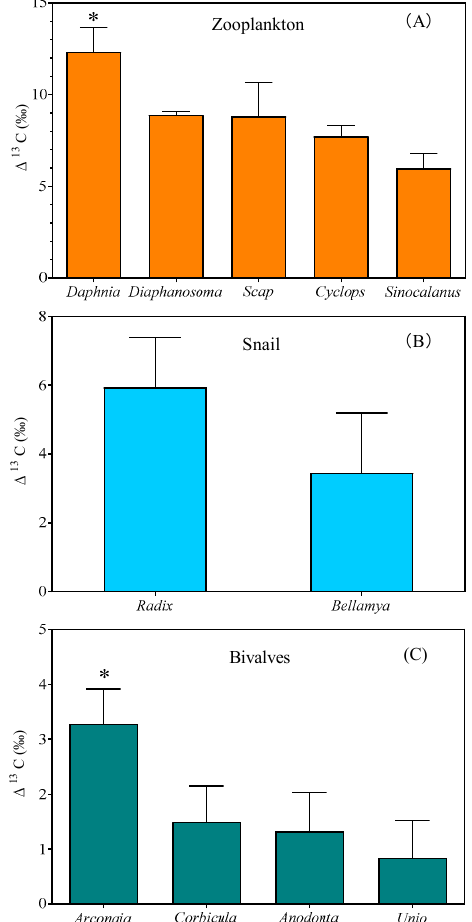
Figure 2. Comparison of 13 C enrichment ( ∆ δ 13 C) of the di ff erent species of cladocerans, copepods, snails and bivalves on δ 13 C peak days during the experiment. Data are presented as averages with SD error bars ( n = 3). Note: * indicate significant di ff erences than other species in each group. ( A ) cladocerans ( Daphnia similis , Diaphanosoma spp. and Scapholeberis kingi ) and copepods ( Sinocalanus dorrii and cyclopoid copepods); ( B ) snails ( Radix swinhoei and Bellamya aeruginosa ) and ( C ) bivalves ( Anodonta woodiana , Unio douglasiae , Arconaia lanceolata and Corbicula fluminea ).